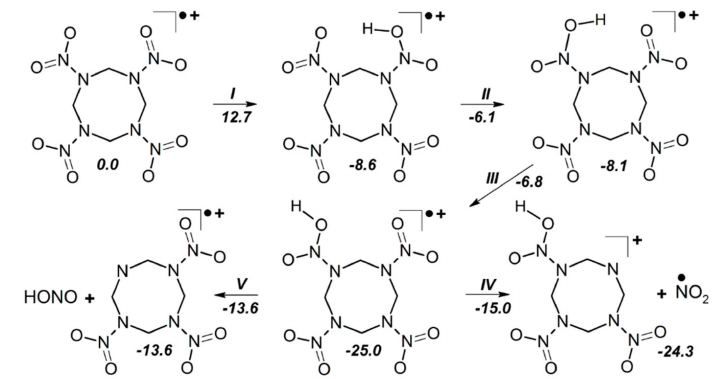
Figure 7. A schematic representation of fragmentation pathways of δ -HMX radical